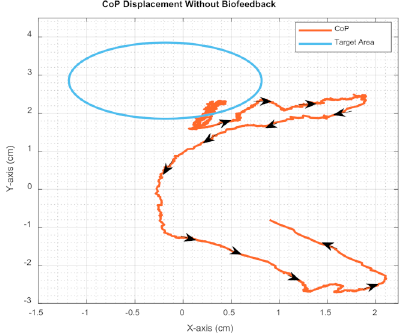
Figure 6. CoP displacement without biofeedback.